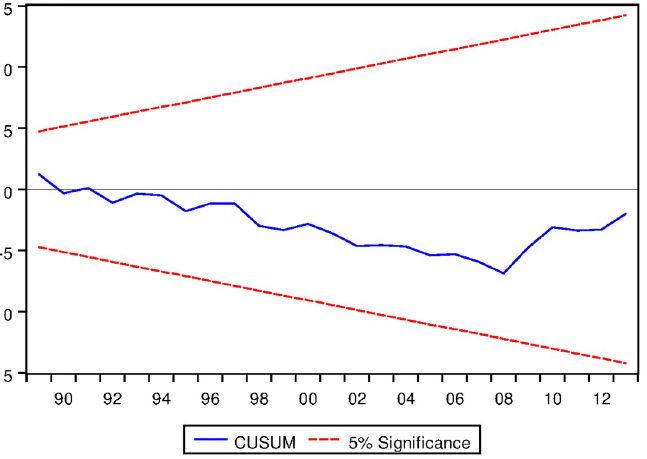
Fig 19. Stability diagnostic of cointegrating relationship for Japanese data with no fixed regressor under proposed framework.